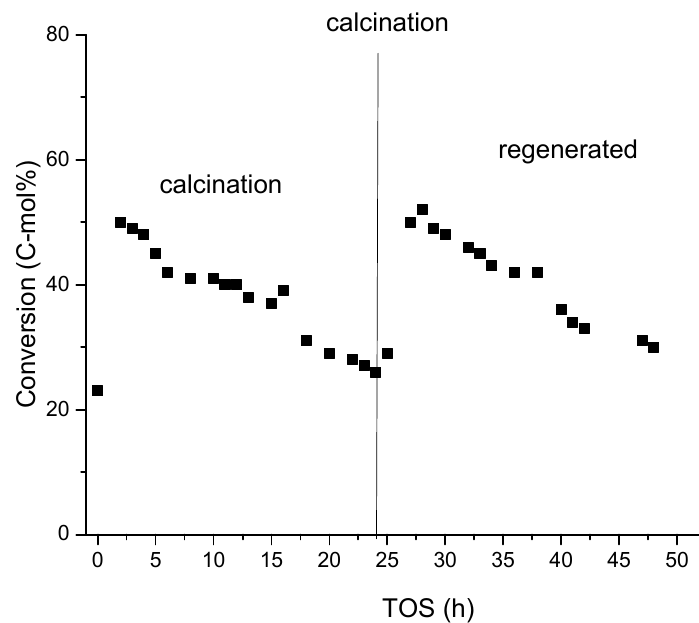
◦ C under 1 bar over MoO 3